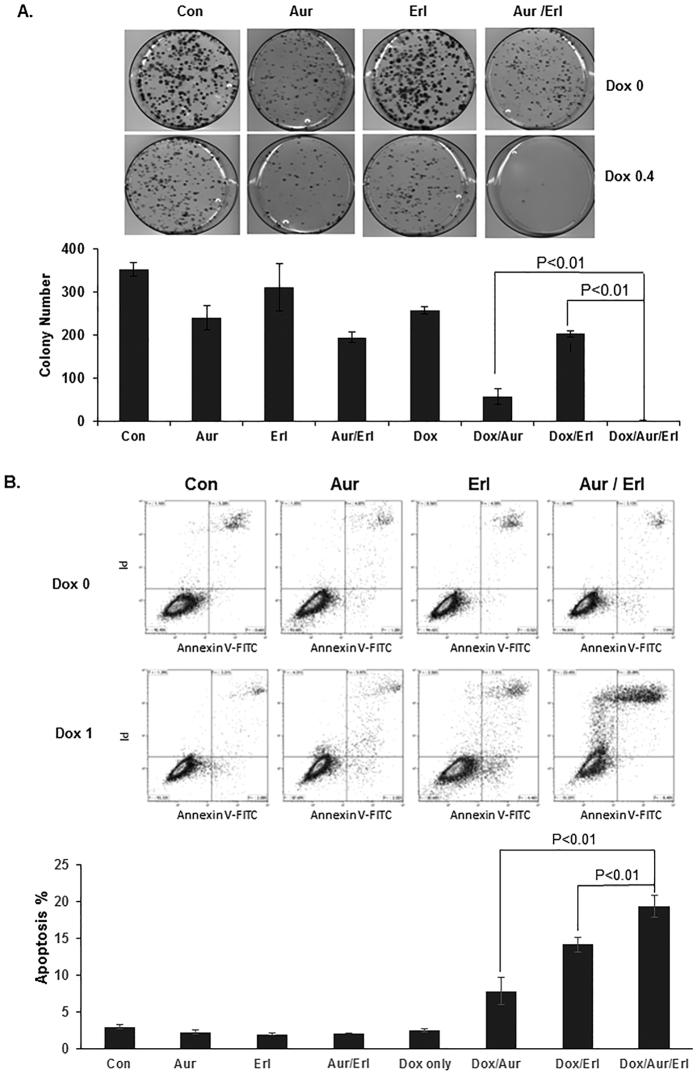
Auranofin/TUSC2/erlotinib reduce tumor cell colony formation and enhance apoptosis synergistically.(A) H1299 Tet-inducible TUSC2 clone was grown in RPMI-1640 medium containing 400 μg/ml G418 prior to treatment with: (1) 0.4 μg/ml Doxycycline; (2) 0.2 μM Auranofin; (3) 0.8 μM erlotinib; (4) 0.4 μg/ml Doxycycline/0.2 μM Auranofin; (5) 0.2 μM Auranofin/0.8 μM erlotinib; and (6) 0.4 μg/ml Doxycycline/0.2 μM Auranofin/0.8 μM erlotinib. Survived colonies were fixed with 3.7% formalin, stained with 1% crystal violet, counted with a stereomicroscope, and analyzed with Image-J software. Values represent the mean of three independent experiments. The statistical significance of differences between treatments was calculated by using three-way ANOVA and two-tailed t test; P < 0.05 was considered significant. The cooperative effect of DC-TUSC2 and erlotinib combination was assessed using a Bayesian parametric bootstrapping approach. The Statistical software S-PLUS 8.0 was used for all analyses. (B) Following treatment of H1299 Tet-inducible TUSC2 clone with 1 μg/ml Doxycycline, 0.8 μM Auranofin, and 0.8 μM Erlotinib, cells were harvested, washed with PBS, and stained with Annexin-V (Promega, Madison, WI). Apoptotic activity was measured by flow cytometry using FlowJo software (Tree Star Corp, Ashland, OR). Values represent the mean of three independent experiments, each in quadruplicate.